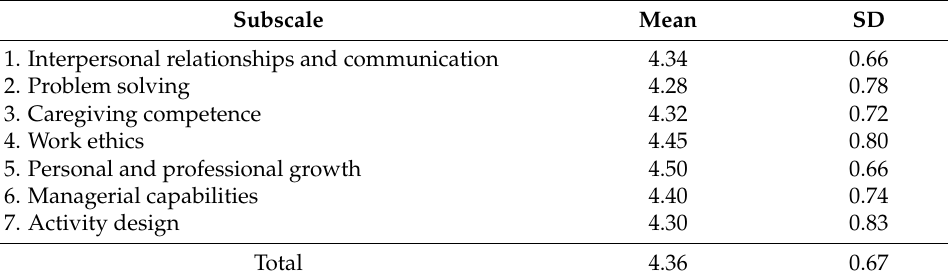
Table 3. Work competence scale self-reported by nurse aides ( N =